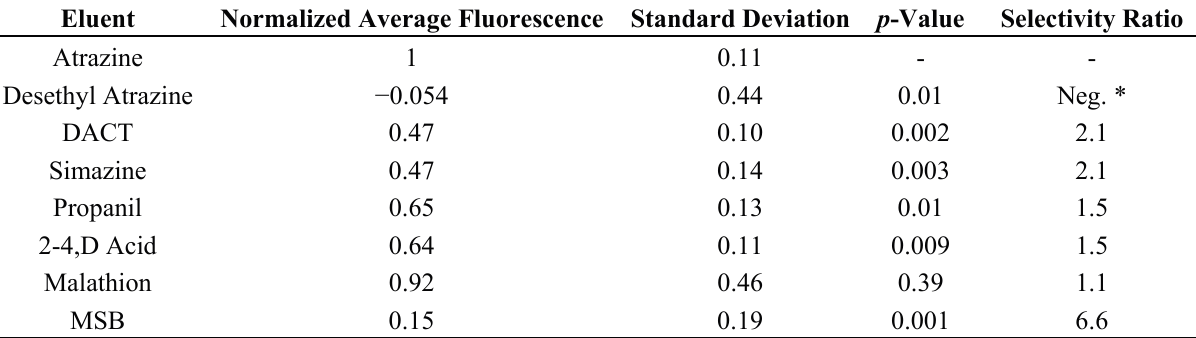
Table 3. Cross-reactivity data of R12.23 ssDNA